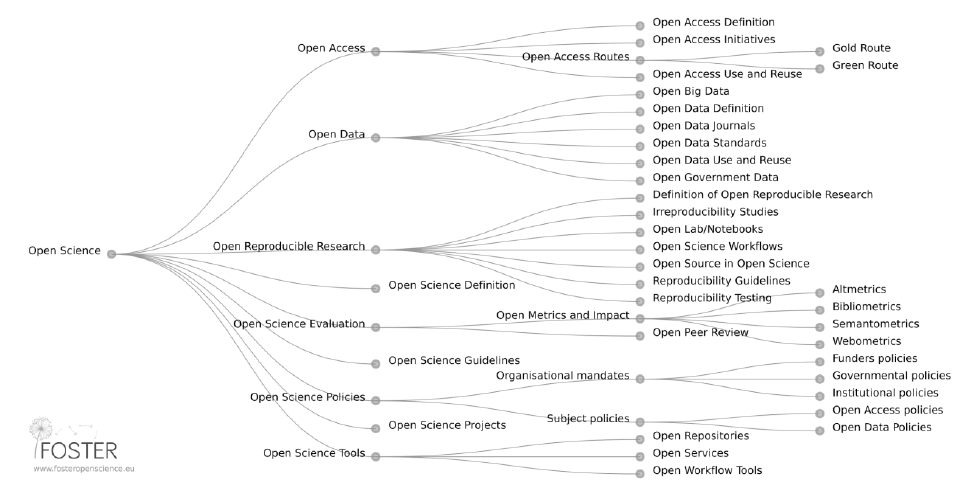
Fig. 2: Foster Open Science Taxonomy. Source: